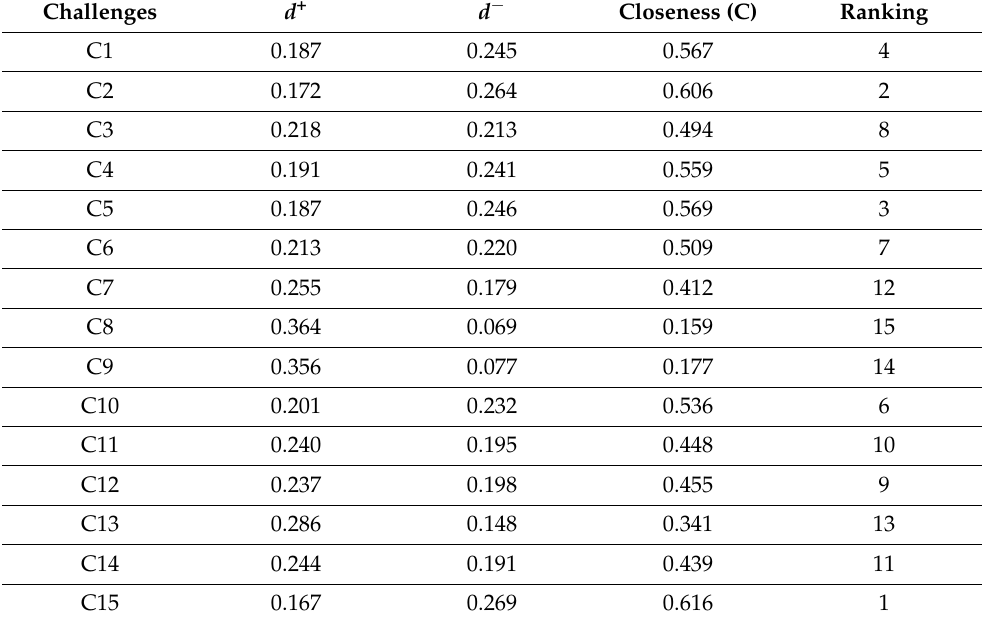
Table 9. Closeness ratings and rankings of